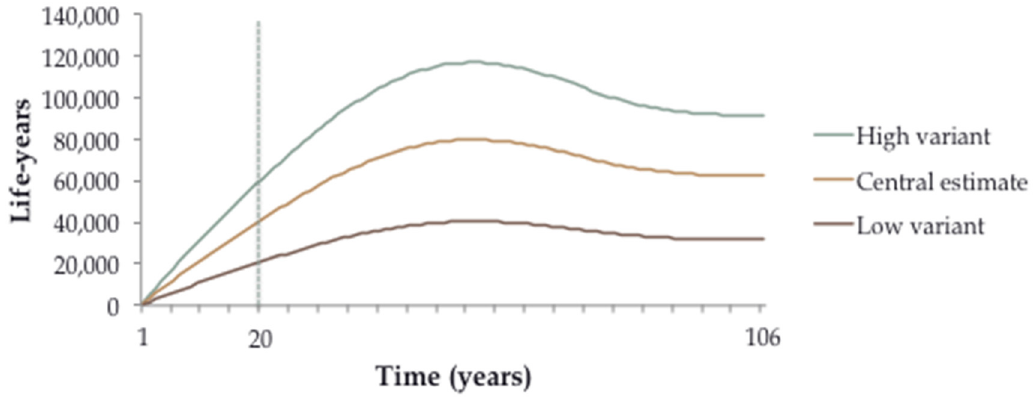
Figure 4. Additional total life-years lived by year in the Fossil Fuel compared to the Ethanol scenario. Low and High variant refers to results estimated using the 5th and 95th confidence intervals in the concentration-response functions, respectively.